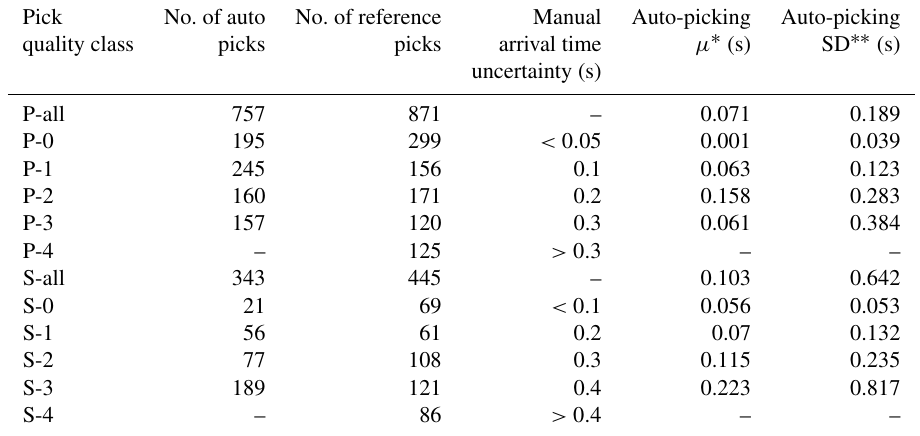
189 121 0.4 – 86 > 0 . 4 – –